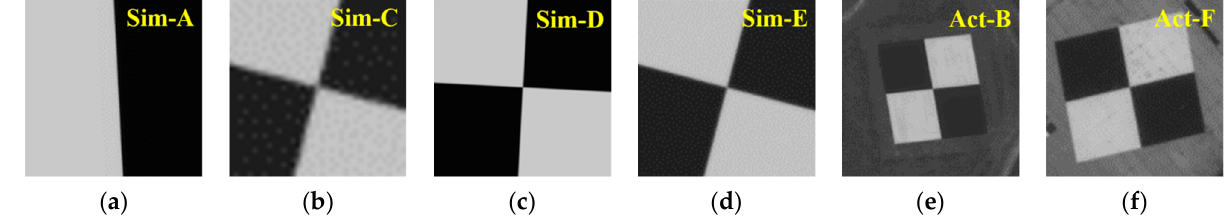
Figure 20. Geospatial quality reference dataset provided by CEOS/WGCV/IVOS: ( a ) Simulated edge image A (200 pix·200 pix), ( b ) Simulated edge image C (50 pix · 50 pix), ( c ) Simulated edge image D (200 pix · 200 pix), ( d ) Simulated edge image E (160 pix · 160 pix), ( e ) Actual edge image B (320 pix · 311 pix), ( f ) Actual edge image F (204 pix · 162 pix).